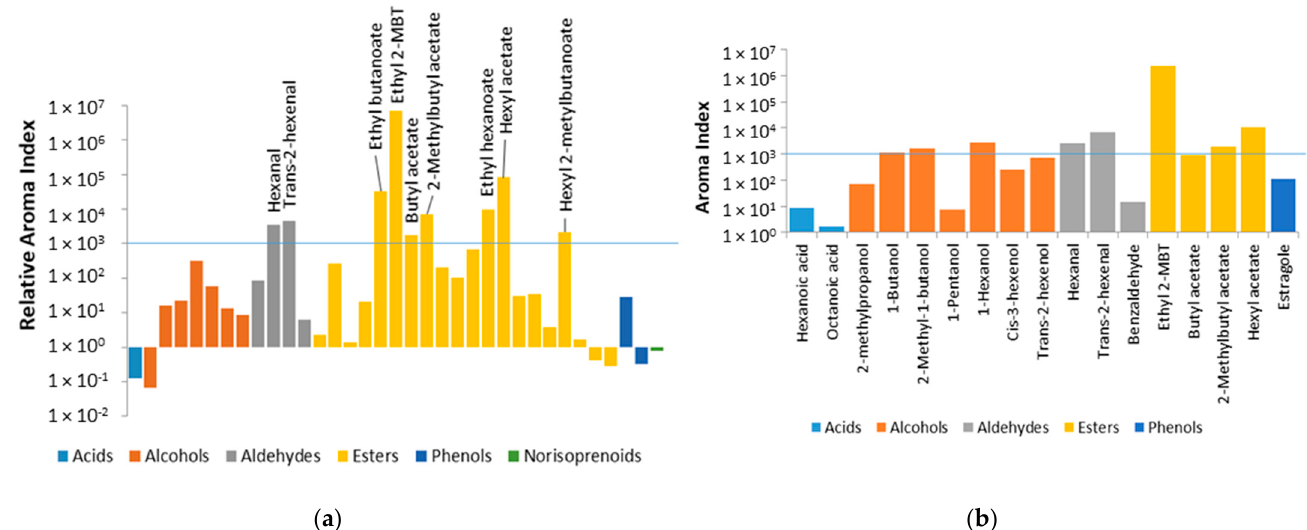
Figure 1. The compounds identified in the apple aroma are plotted in a logarithmic scale against its own contribution to the aroma; values higher than 1 can contribute to aroma, values higher than 1000 present an odor intensity in the supra- threshold area (blue line). The GC peak area obtained by Headspace–Solid Phase Microextraction Gas Chromatography Combined with Quadrupole Mass Spectrometry (HS–SPME/GC–qMS) was divided by the odor threshold given by the ( a ) Relative Aroma Index (the compounds corresponding to each bar are presented in Table 1 in the same sequence); ( b ) the concentration calculated by Simultaneous Distillation Extraction (SDE)/GC–qMS divided by the odor threshold given by the Aroma Index. Ethyl-2-MBT: ethyl-2-methylbutanoate.